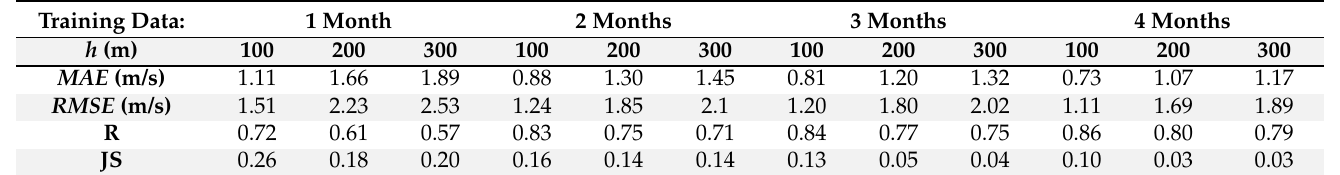
Table 5. Wind speed error variation as a function of the amount of training data for the bagging regressor.